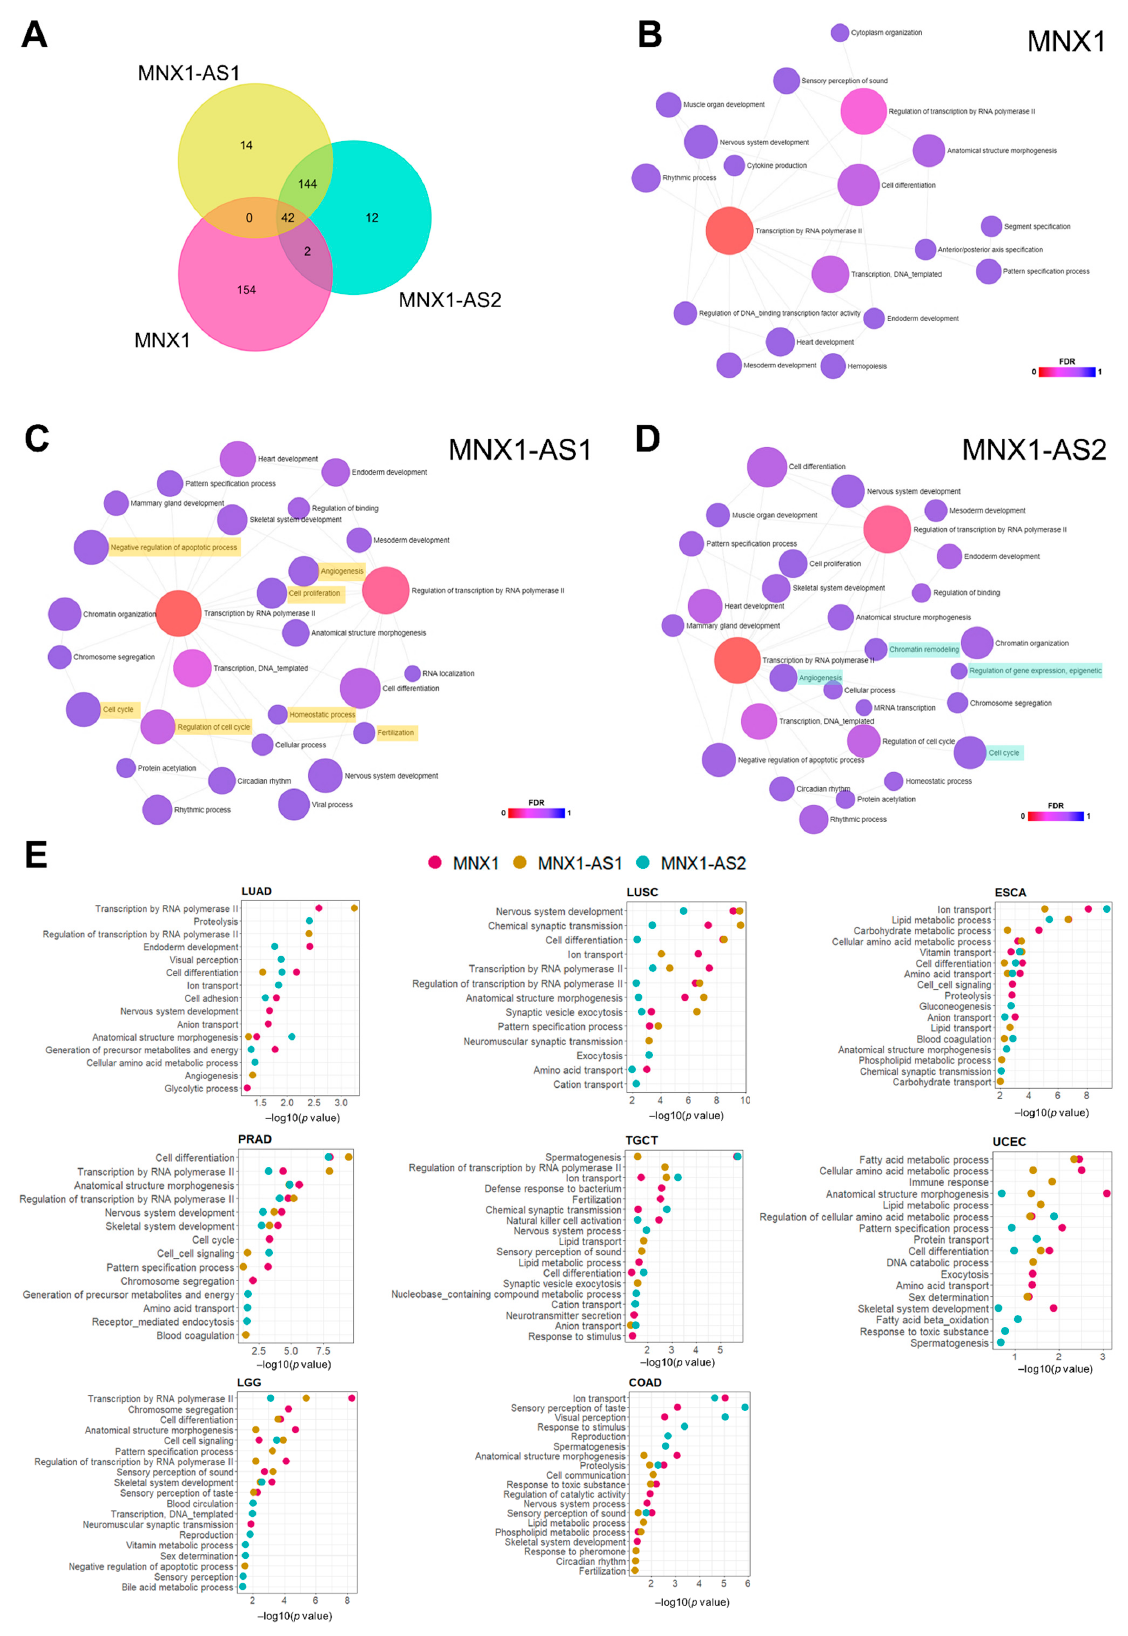
Figure 6. Functional prediction of MNX1 , MNX1 - AS1 , and MNX1 - AS2 functions in cancer